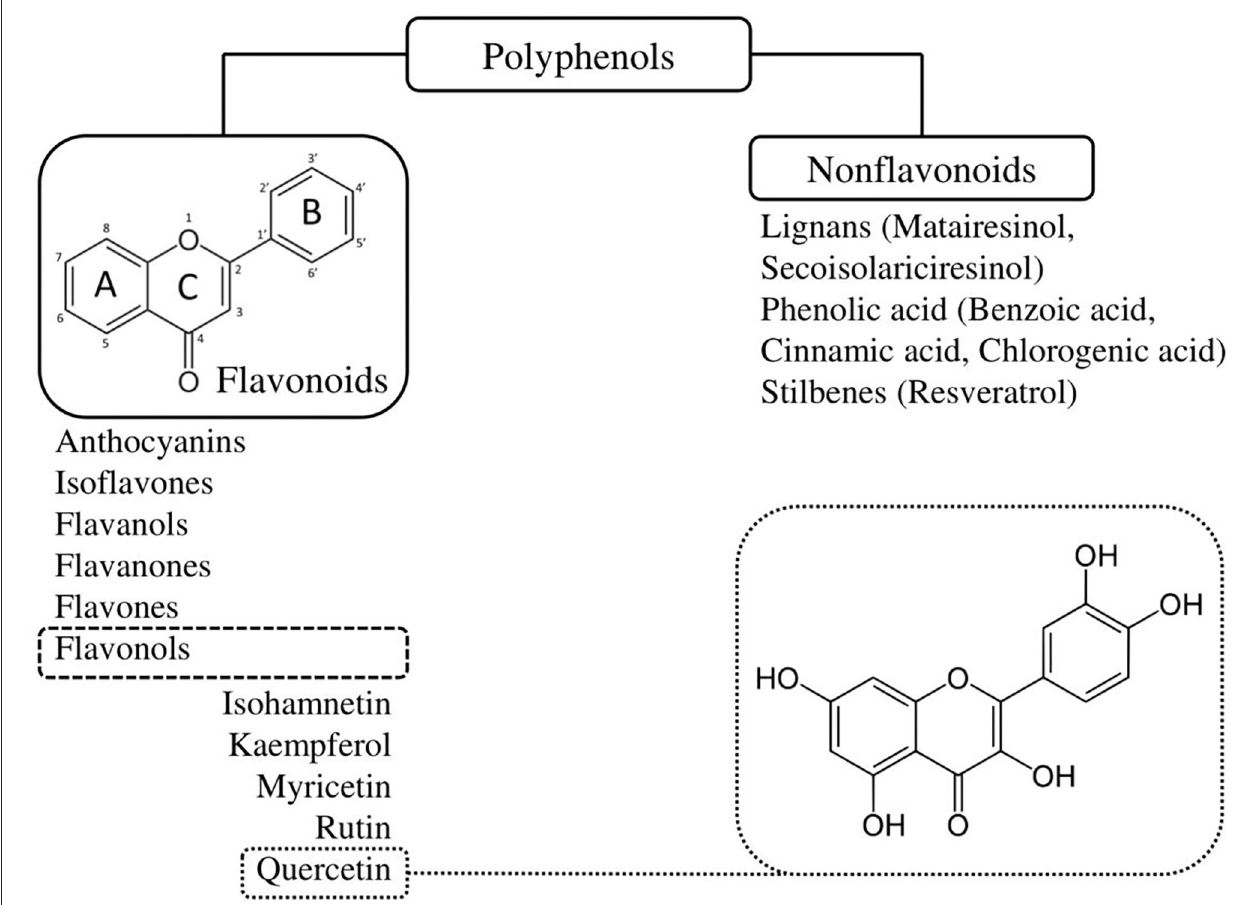
FIGURE 2 | Classification and chemical structure of quercetin, a family member of flavonoids. Quercetin is a pentahydroxyflavone, having five hydroxyl groups placed at the 3-, 3’-, 4’-, 5-, and 7-positions. Combined with the pyrocatechol, a benzene ring, this chemical structure allows them to act as radical scavengers, explaining, in part, quercetin’s strong antioxidant